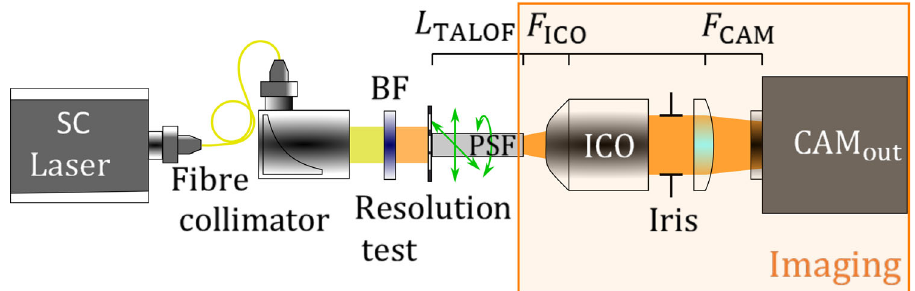
Fig. 7 Setup for classical light experiments. Classical imaging apparatus. White light from the supercontinuum (SC) laser is collimated and fi ltered with a bandpass fi lter (BF). Images are generated with a resolution test target and inserted into the PSF directly without any optics; that is, resolution test target and phase-separated fi ber (PSF) are in contact. L TALOF denotes the length of the PSF. An in fi nity-corrected objective (ICO) collects the PSF output. A CMOS camera (CAM out ) captures images. Focal lengths F ICO , F CAM are discussed in the corresponding